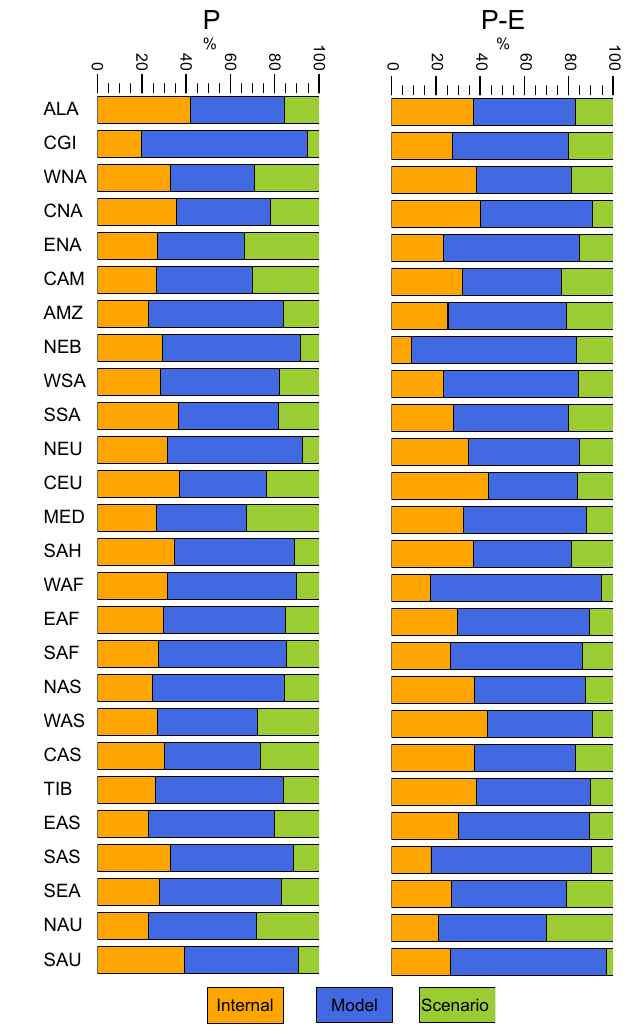
Figure 9. Sources of uncertainty in the sensitivity of P (left) and P − E (right) to a global mean temperature change of 1K averaged over each SREX region as outlined in Fig. 3.